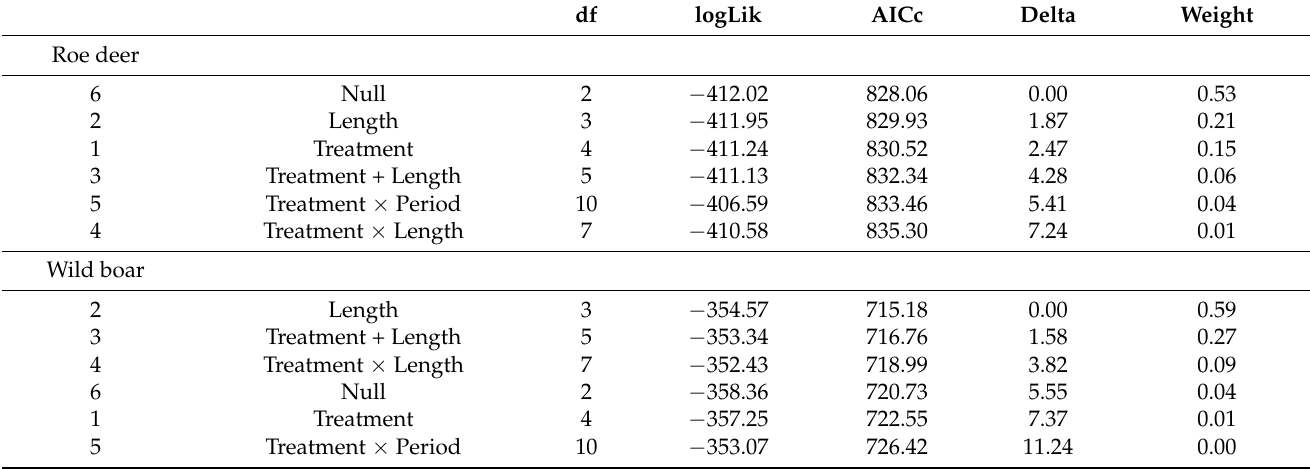
Figure 3. Correlations between occurrence probability of roe deer and wild boar and time length of experiment. Predicted values were obtained by model 2 for roe deer which had comparable performance to the null model (the best model), but indicating a non-significant effect of Length on detection probability. Shaded areas indicate the 95% confidence intervals for the predicted values. Table 3. Rank of logistic regression models for detection probability of roe deer and wild boar based on AICc. The best model is shown in bold. df